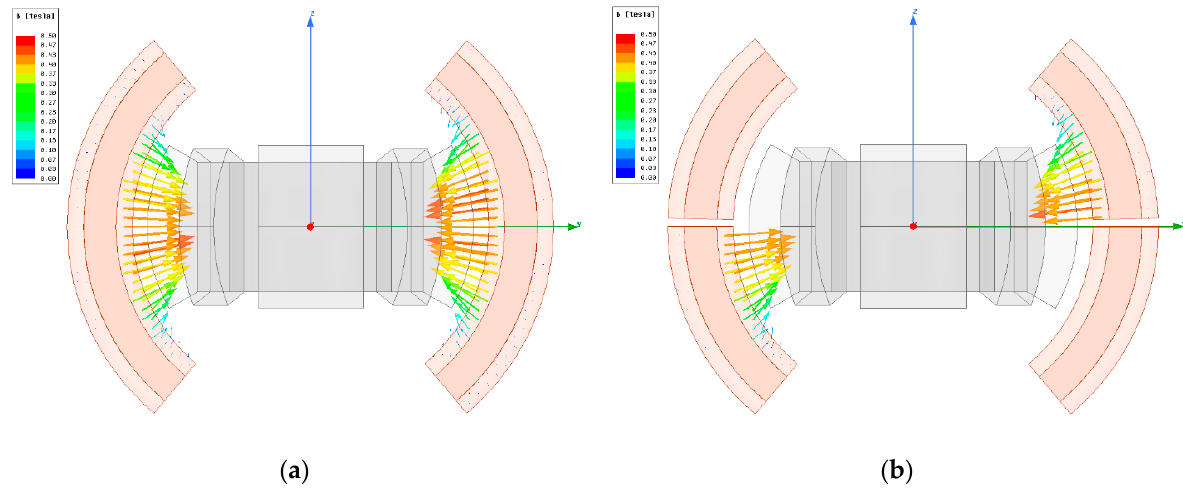
Figure 8. Magnetic flux density distribution of Y-Z cross-section when the rotor is rotating around the X -axis at 0° for ( a ) original and ( b ) proposed 3-DOF spherical motor, respectively.